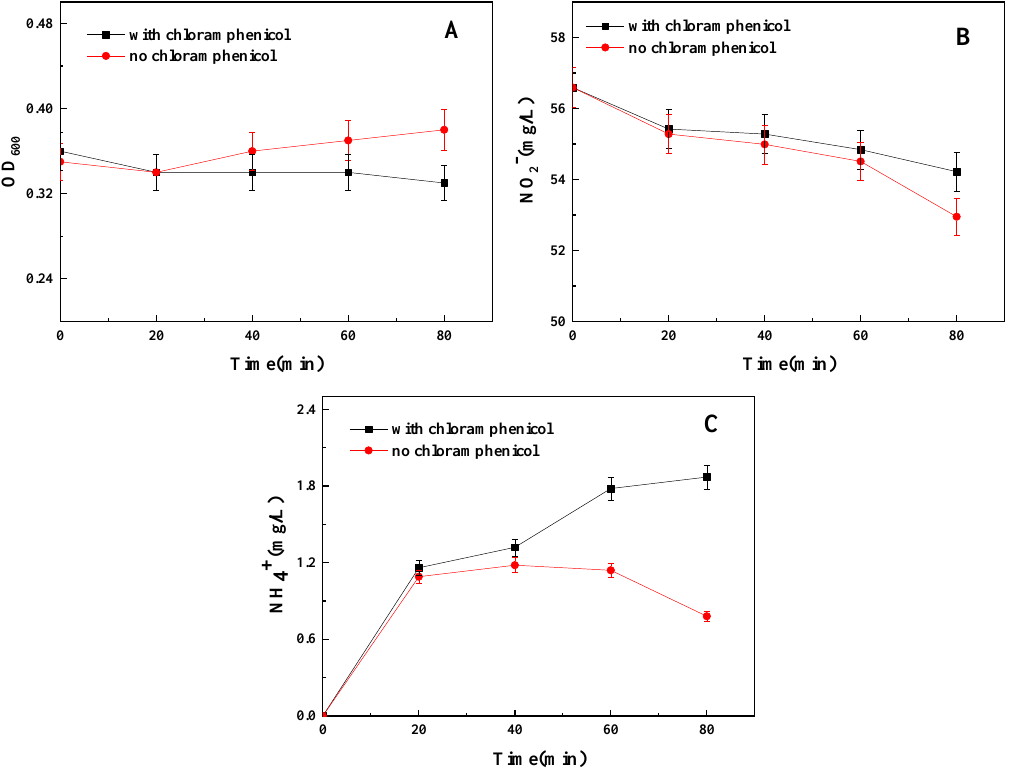
Figure 1. Influence of chloramphenicol on OD 600 ( A ), NO 2 − ( B ), and NH 4 + ( C ) by strain Y-9. Values are means ± SD for triplicates.